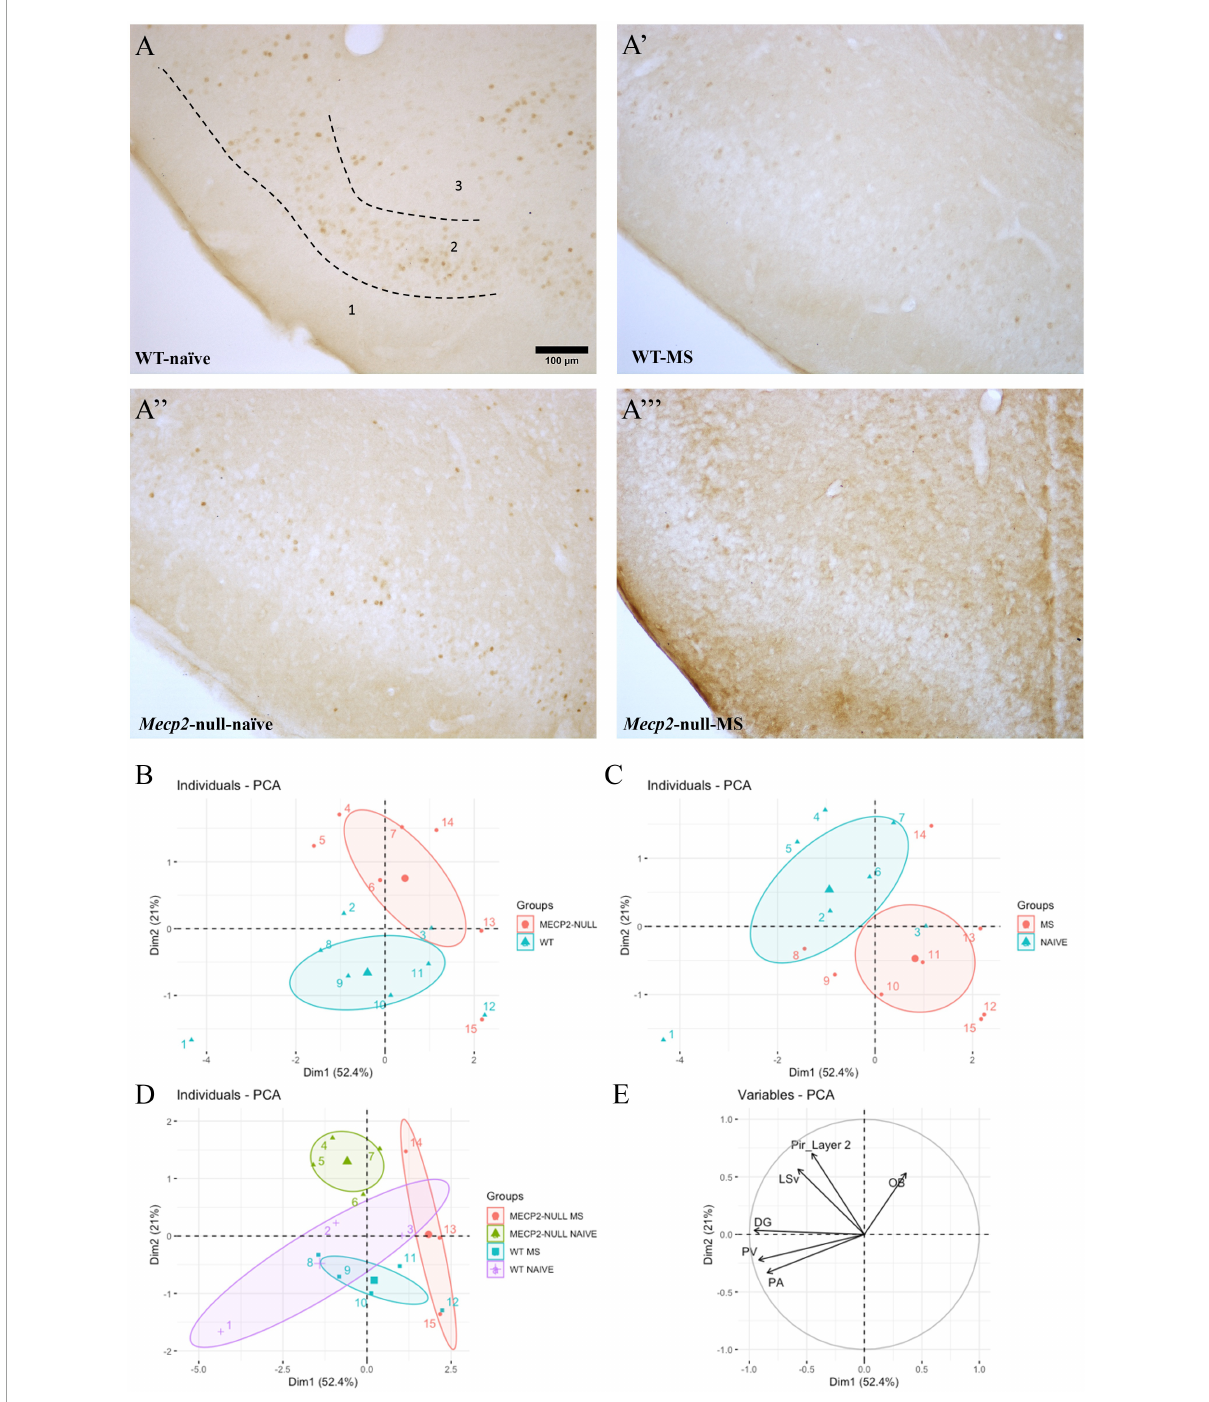
FIGURE3 Exposure to the EPM in bright conditions leads to differential c-FOS activation at multiple brain areas that is genotype- and group-dependent. One hour after the re-exposure to the EPM behavioural test under bright conditions, a batch of animals from each genotype x treatment were culled to assess c-FOS immunoreactivity (c-FOS-ir; n = 3-6, depending on genotype/treatment/area). Representative photomicrographs from c-FOS immunostaining at the Pir from (A) WT-naïve, (A’) WT-MS, (A”) Mecp2 -null-naïve, (A”’) Mecp2 -null-MS. Scale bar represents 100 µ m. Principal component analysis of c-FOS expression profiles at the different areas studied are coloured according to (B) genotype, (C) group or (D) both; (E) arrows displaying the weight of the variables (brain areas) for both first and second principal components. Graphs show individual values and mean for each group. DG, dentate gyrus of the hippocampus; OB, olfactory bulb; PA, paraventricular hypothalamic nucleus; PV, paraventricular thalamic nucleus; Pir, piriform cortex; LSV, ventral part of the lateral septum; EPM, elevated plus maize; MS, maternal separation; WT,